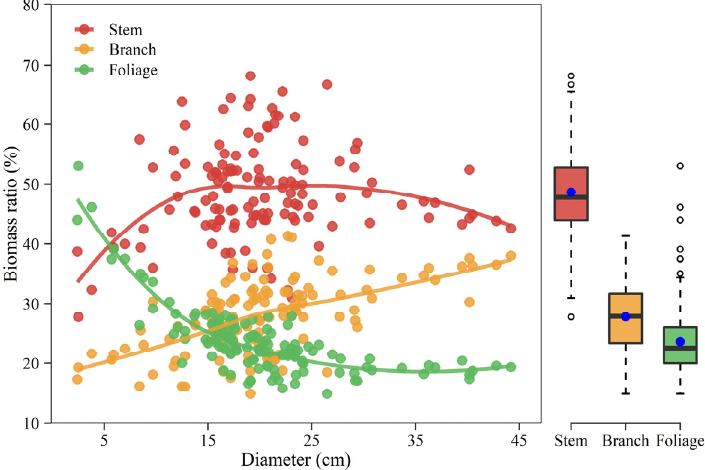
Figure 6. Percentage of component biomass varies against diameter at breast height and the marginal boxplot shows the distribution of component biomass ratios. The solid line indicates loess smoothing. The length of the box indicates the 25th–75th percentile, the blue dot inside the box represents the mean value, the horizontal line inside the box represents the median, and outliers are marked as hollow circles.